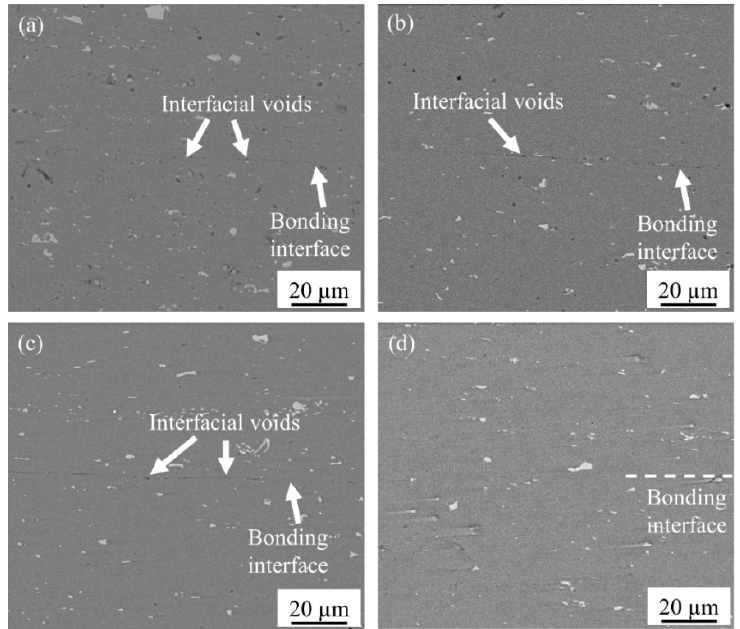
Figure 2. Microstructures of AA6061/AA6061 bonding interfaces after diffusion bonding at ( a ) 500 °C, ( b ) 510 °C, ( c ) 520 °C, and ( d ) 530 °C for 30 min.